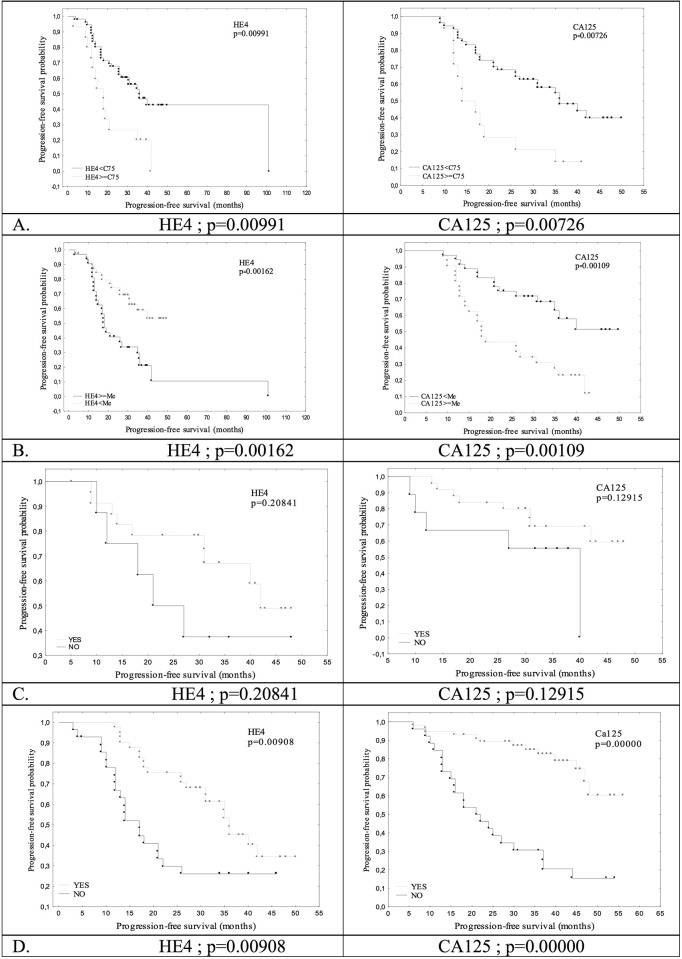
Progression-free survival stratified by HE4 and CA125 in the examined patients with ovarian cancer.(A) Stratified by the preoperative serum marker levels (75 percentile) in the whole group. (B) Stratified by the preoperative serum marker levels (median) in the whole group. (C) Stratified by the 50% reduction of serum marker levels after the surgical treatment in patients after the primary debulking surgery. (D) Stratified by normalization after the last course of chemotherapy in the whole group.